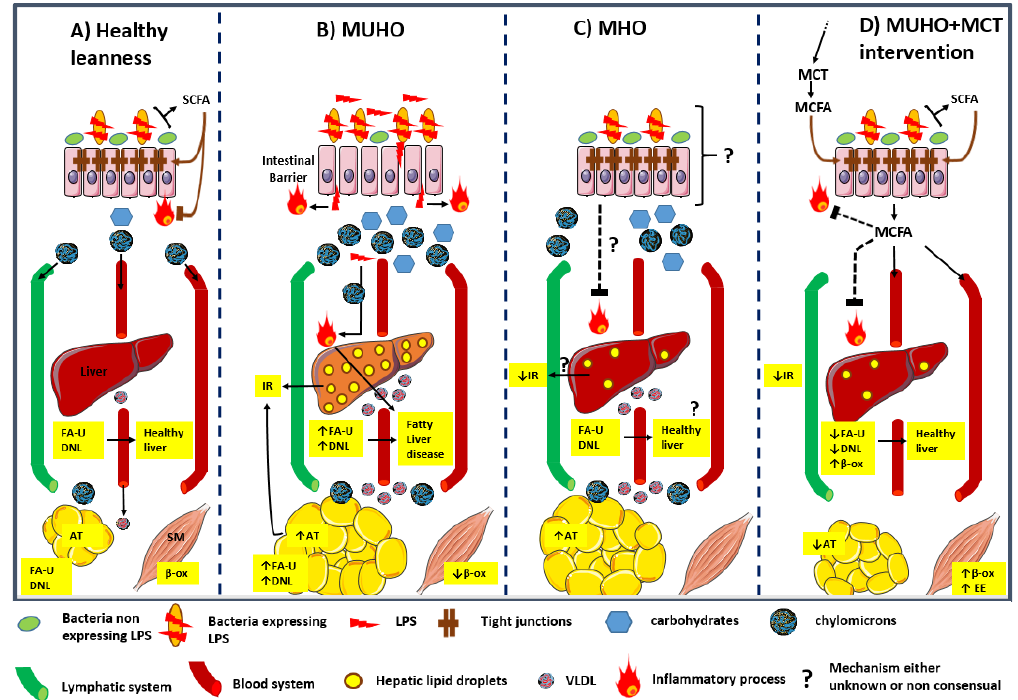
Figure 1. Crosstalk between gut, liver and peripheral metabolic tissues under 4 metabolic states. Under condition of healthy leanness ( A ) an optimal relative abundance of LPS-expressing vs . non-expressing bacteria contribute to gut impermeability, low intestinal and hepatic inflammation, and non-obesogenic/steatogenic nutrient supply. Under MUHO conditions ( B ), an elevation in the relative abundance of LPS-expressing bacteria (Gram-negative) induces LPS infiltration and leads to altered intestinal barrier integrity, local inflammation, liver injury and endotoxemia. At the same time, a high fat and carbohydrate supply contributes to adiposity, hepatic steatosis and peripheral insulin resistance. In MHO subjects ( C ), despite an adiposity sustained by a rich diet, a balanced gut microbiota would contribute to maintain intestinal and systemic metabolic health, prevent endotoxemia, and lower hepatic injury and peripheral insulin resistance. Our hypothetical model ( D ) suggests that diet MCT supplementation for MUHO subjects may facilitate a shift towards an MHO-like profile by into a metabolically beneficial structure. SCFA: short chain fatty acids; FA-U: Fatty acid uptake; AT: adipose tissue; DNL: de novo lipogenesis; SM: skeletal muscle; MUHO: metabolically unhealthy obese (or obesity); IR: Insulin resistance; β -ox: beta-oxidation; MHO: metabolically healthy obese (or obesity); very low density